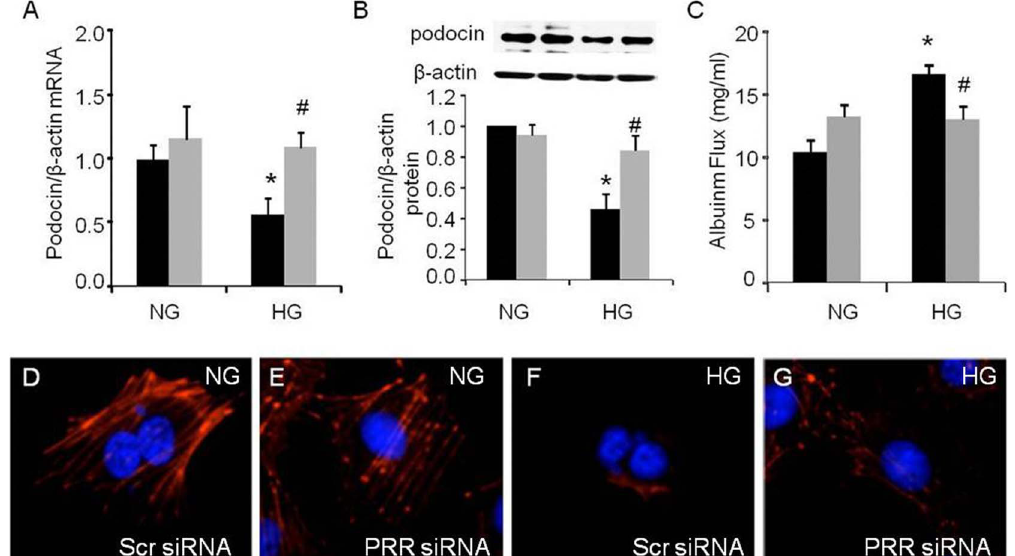
Figure 7. Effect of PRR siRNA on high glucose induced podocyte structure and function. A. Real time PCR analysis of podocin mRNA expression (n=5); B. Western blot analysis of podocin protein expression (n=5); C. Analysis of the albumin flux across podocytes monolayer at 2 hours (n=4); D, E, F and G. Immunofluorescence staining of F-actin shown in red, DAPI shown in blue (n=5). PRR, (Pro)renin receptor; Normal glucose, 5 mM D-glucose (NG); high glucose, 25 mM D-glucose (HG). Black bar, Scrambled siRNA; Grey bar, PRR siRNA. Data presented as mean 6 SEM, * p , 0.05 vs NG + Scrambled siRNA; # p , 0.05 vs HG + Scrambled siRNA.